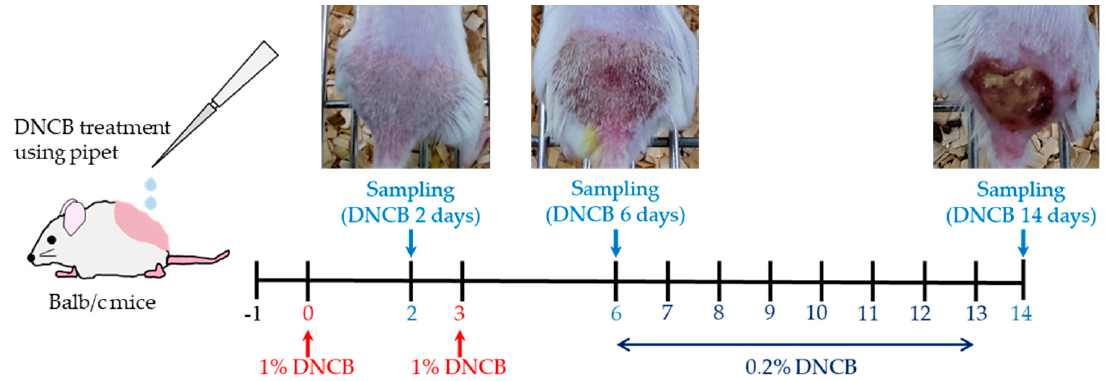
Figure 1. Study design for the induction of atopic dermatitis (AD) in the animal model using 2,4-dinitrochlorobenzene (DNCB). The DNCB 2 days group was induced by one treatment with 1% DNCB. For the DNCB 6 days group, AD was induced by treatment with DNCB once per day on day 0 and day 3. Finally, the DNCB 14 days group was sensitized with 1% DNCB on day 0 and day 3, and then subsequently treated with 2% DNCB daily from day 6 to day 13.